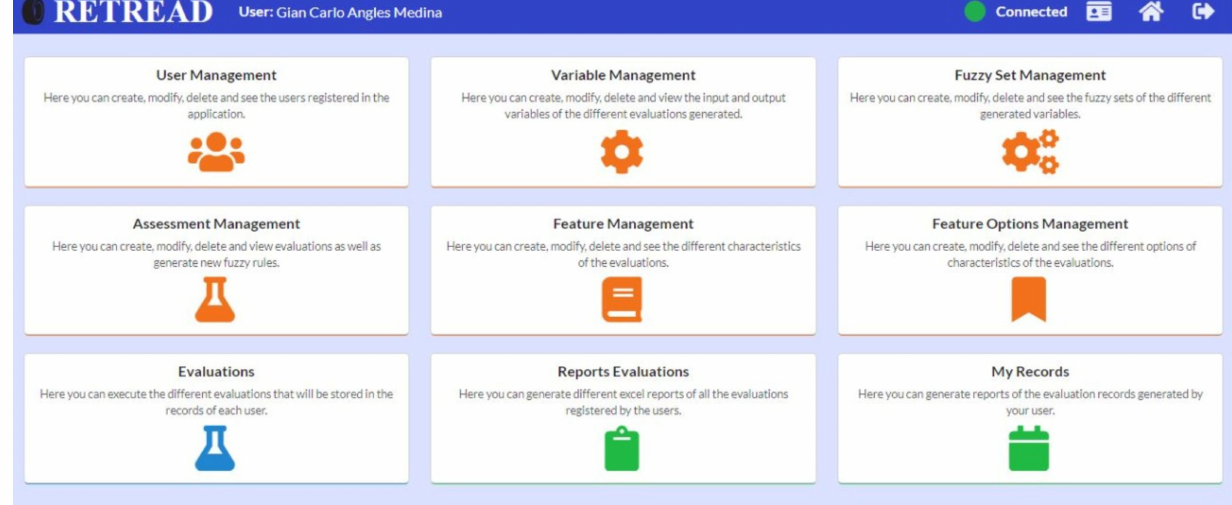
Figure 6. Main Screen of the Tire Diagnostic